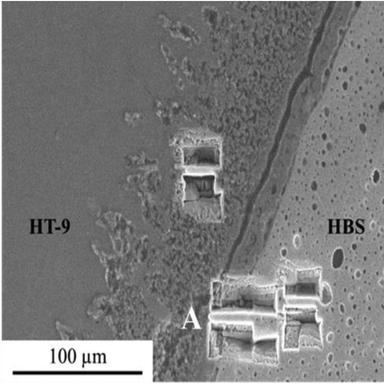
SEM image of MA-MOX fuel. The FCCI zone and the location of the TEM foils extracted for analysis of the samples..